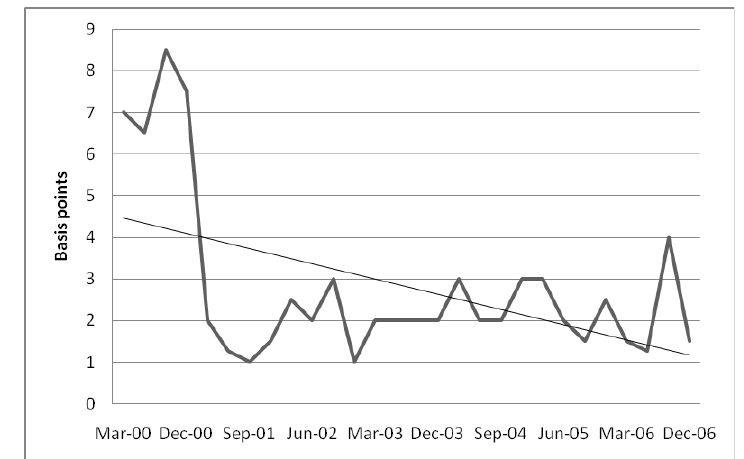
FIGURE 5b: 4-quarter-ahead forecasts